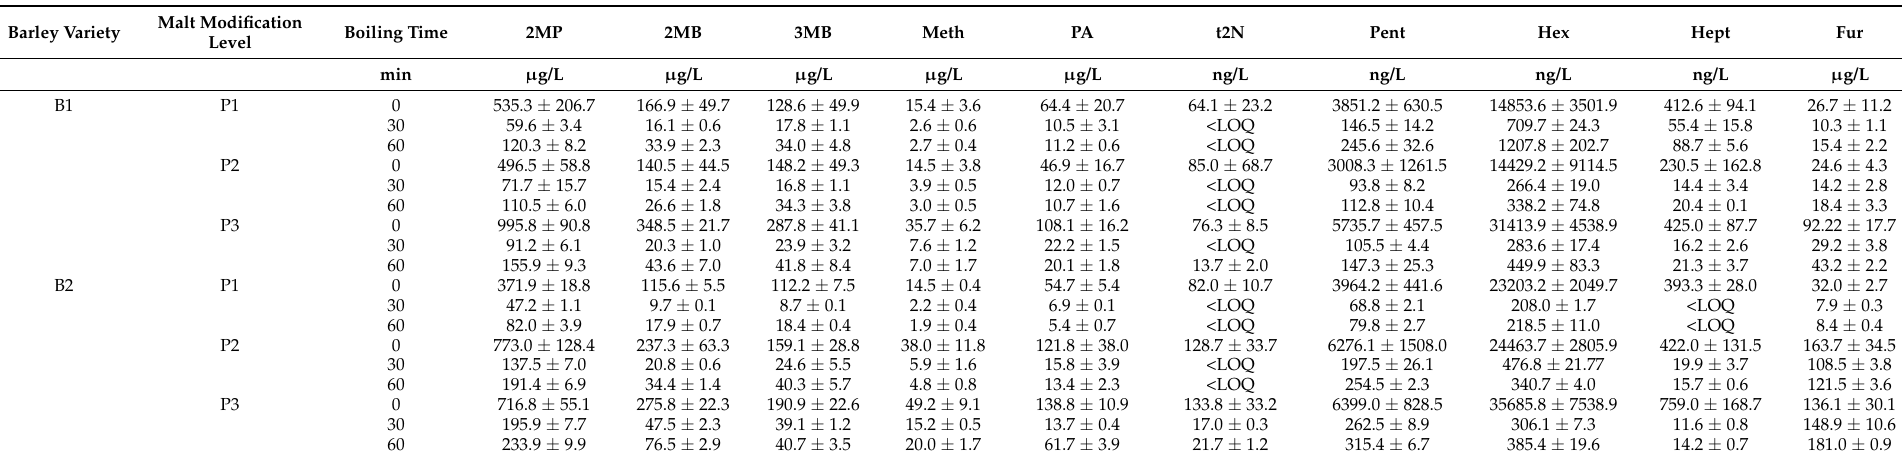
Table 4. Formation of wort carbonyls of B1 (Avalon) and B2 (Marthe) during wort boiling, n =